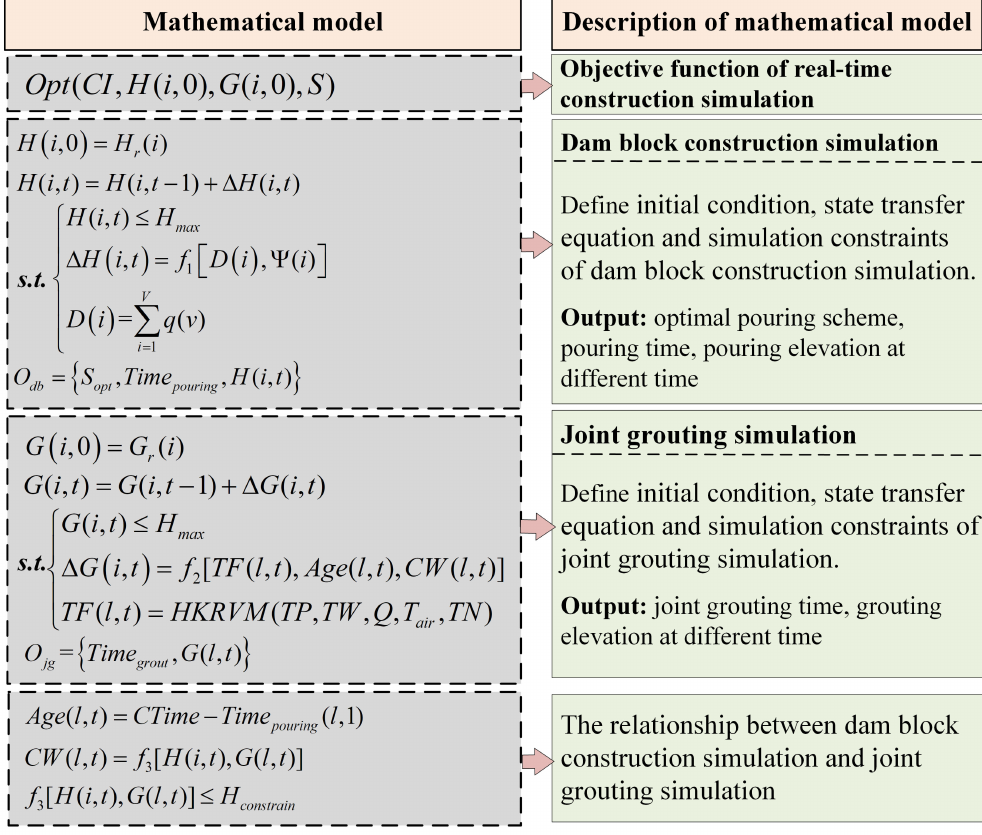
Figure 2. The real-time construction simulation mathematical